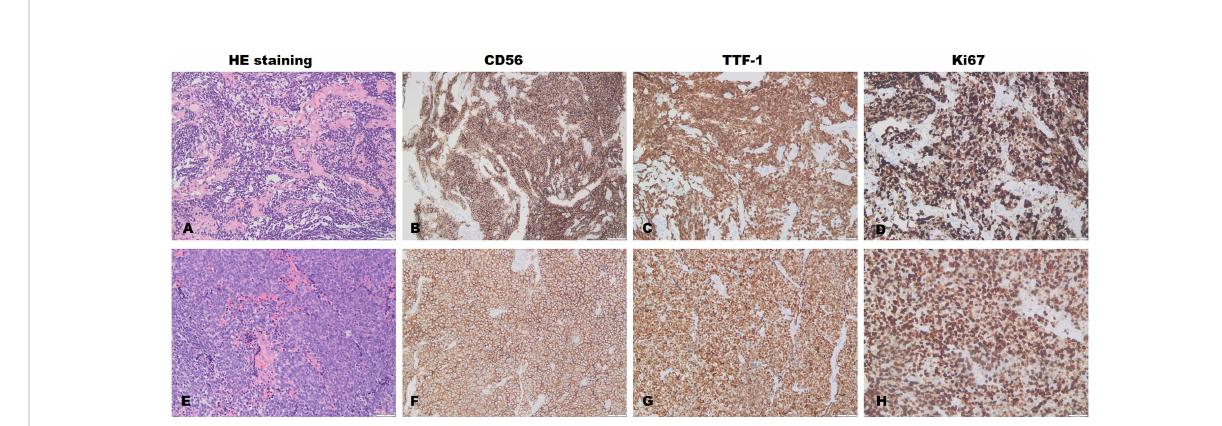
FIGURE 3 Lung (A – D) and lymphatic node (E – H) pathological examination. The pathological results of the lung of Patient 6 suggest small-cell lung cancer. Immunohistochemical results: The positive rates of CK (+), TTF-1 (+), syn (+), CD56 (+), CGA (-), CK7 (-), CK5/6 (-), and P40 (-); the positive rate of Ki-67 was approximately 80%. The pathological results of the right cervical lymph nodes in Patient 5 were indicative of metastatic small-cell carcinoma of the lung. Immunohistochemical results: The positive rates of CK punctate weak (+), CK7 (-), TTF-1 (+), syn (+), CGA punctate weak (+), CD56 (+), p63 (-); the positive rate of Ki-67 was approximately